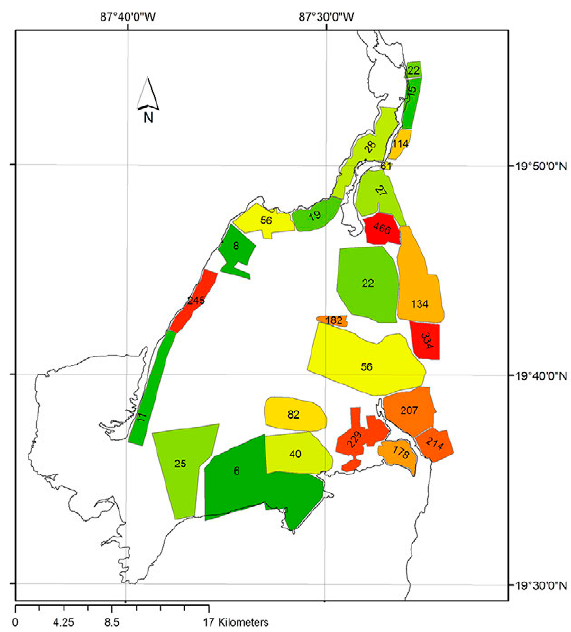
Fig. 2. – Density of artificial shelters (shelters km –2 ) per fishing area.